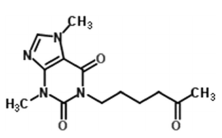
Fig. 1. Structure of Pentoxifylline, a tri (cid:2) substituted xanthine derivative designated chemically as 1-(5-oxohexyl)-3,7-